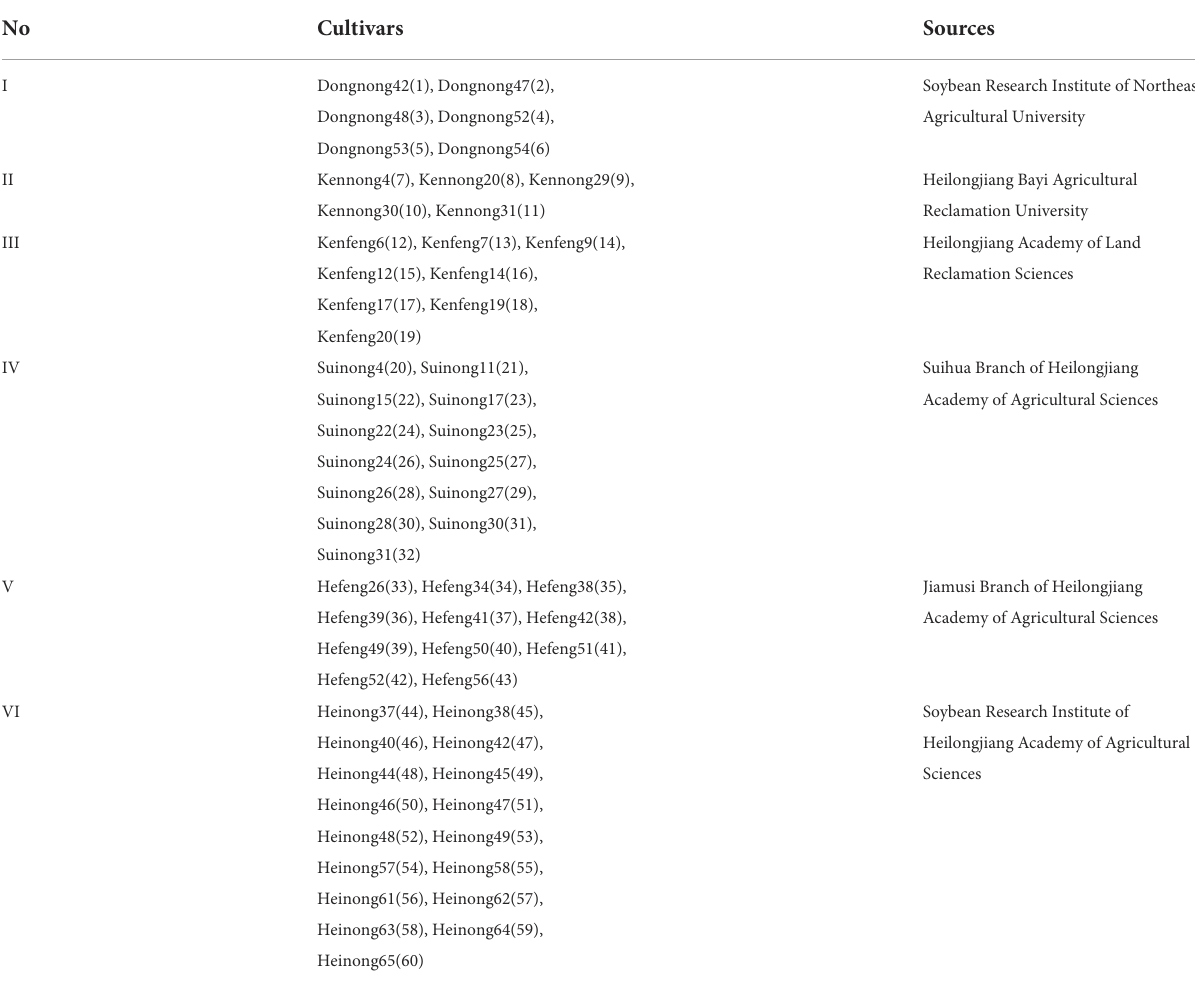
TABLE 1 Cultivars